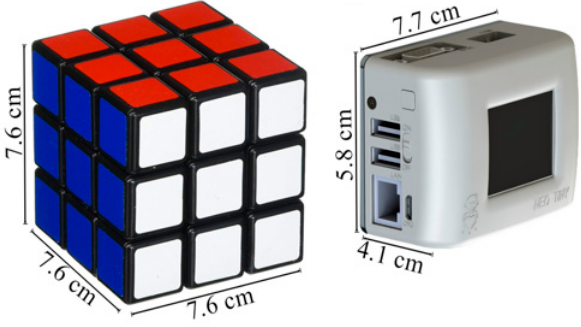
Figure A2. Size comparison of a 3 × 3 Rubik’s cube and NEO TINY system client.